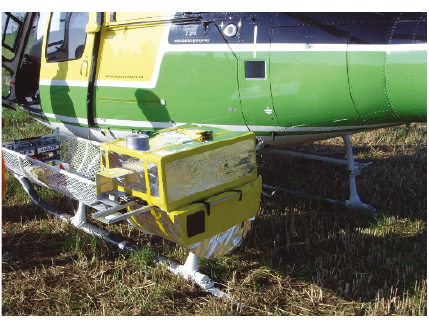
Figure 9: Helicopter-mounted payload.